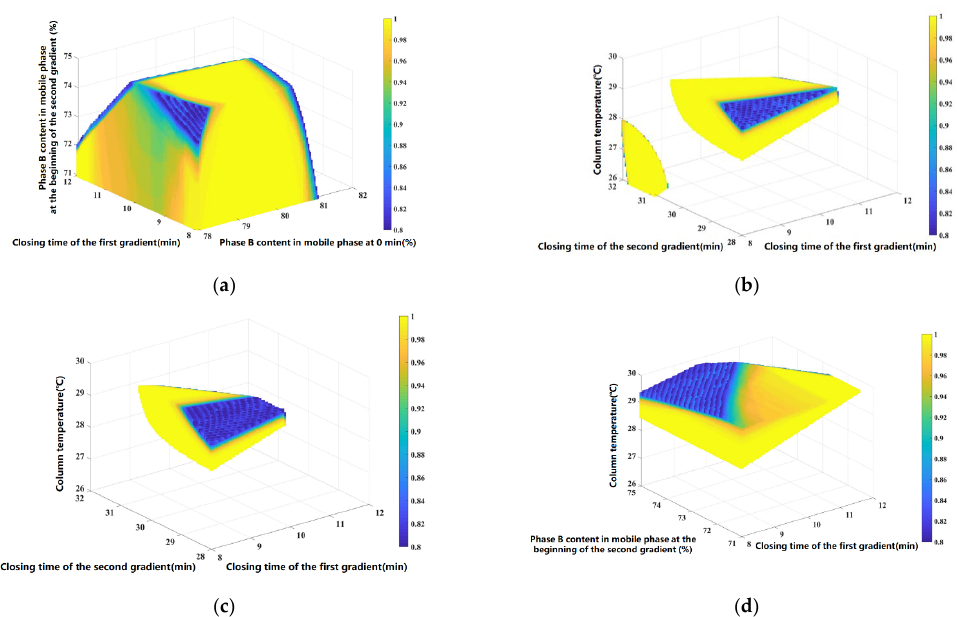
Figure 3. The MODR calculated using the experimental error simulation method. ( a ) Closing time of the second gradient was 28 min; column temperature was 30 °C; rate of flow was 0.6 mL/min; ( b ) Phase B content in mobile phase at 0 min was 81%; phase B content in mobile phase at the beginning of the second gradient was 74%; rate of flow was 0.6 mL/min; ( c ) Phase B content in mobile phase at 0 min was 81%; phase B content in mobile phase at the beginning of the second gradient was 75%; rate of flow was 0.6 mL/min; ( d ) Phase B content in mobile phase at 0 min was 81%; column tem- perature was 28 °C; rate of flow was 0.6 mL/min.